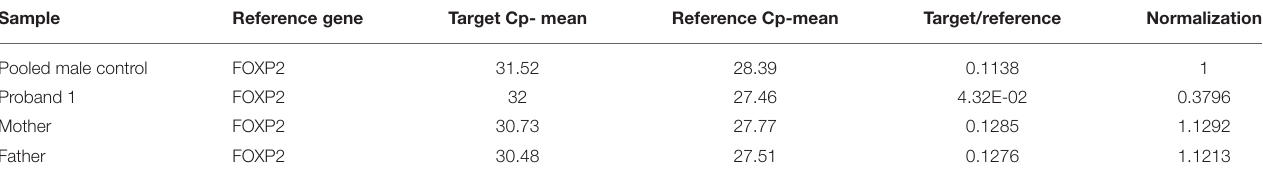
TABLE 2 | Q-PCR analysis results of proband 1, his parents and the five pooled male controls by using primer pair 2 at intron 19 of STXBP1